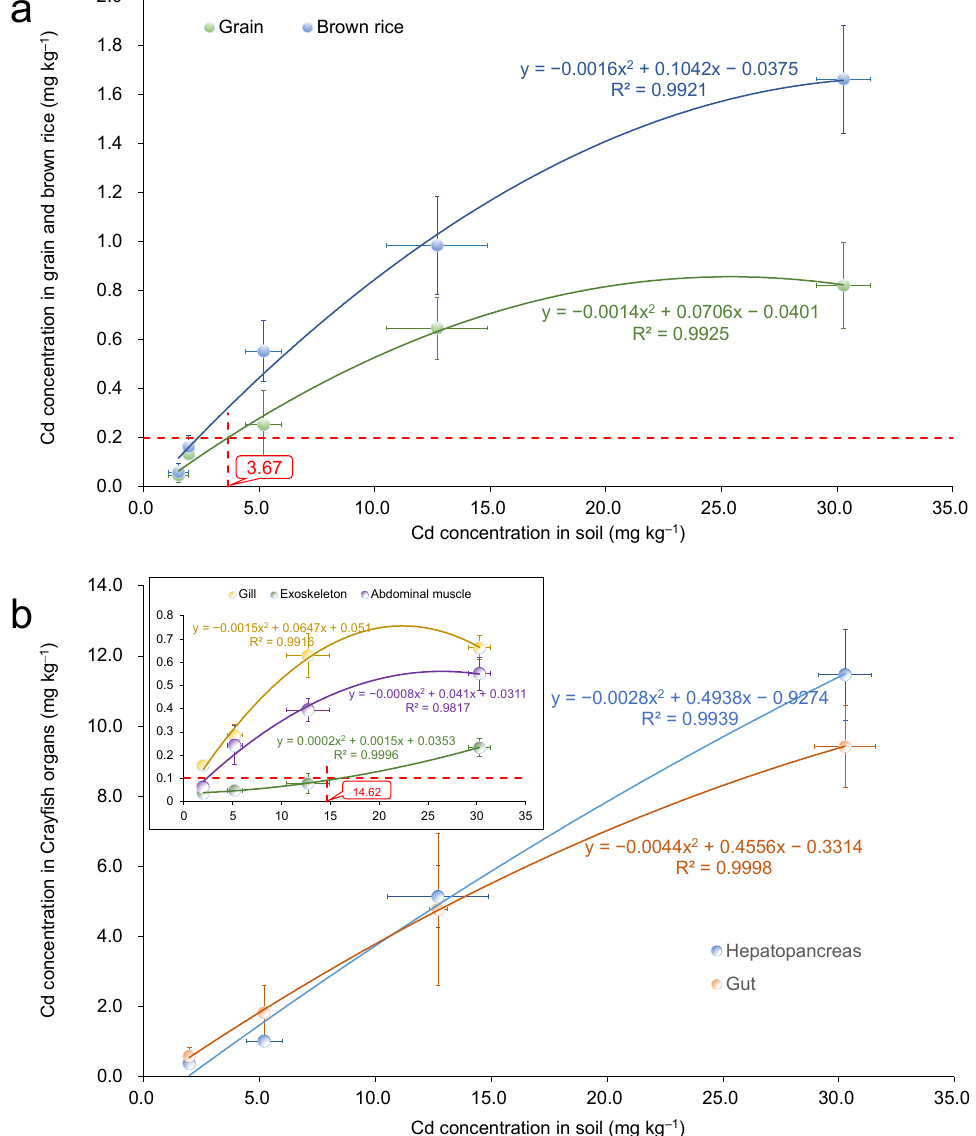
Figure 5. The Cd concentration in rice tissues and crayfish organs of different treatments. The red horizontal dotted line represents the limit standard of Cd in brown rice of China (0.2 mg kg − 1 ) in ( a ); thus, the safety threshold of soil Cd for brown rice in the RCC was calculated to be 3.67 mg kg − 1 . The red horizontal dotted line represents the limit standard of Cd in crustaceans of China (0.1 mg kg − 1 ) in ( b ); thus, the safety threshold of soil Cd for crayfish muscle in the RCC was calculated to be 14.62 mg kg − 1 .